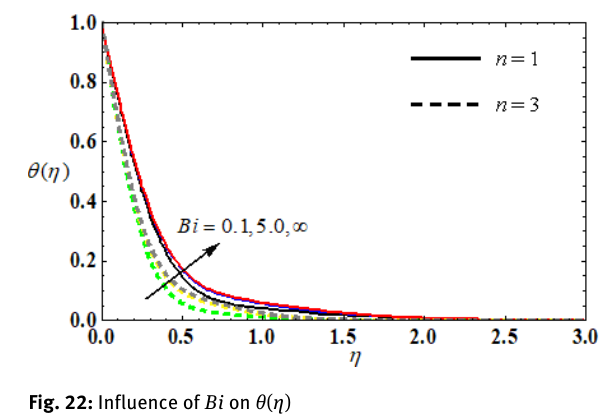
Fig. 22: Influence of Bi on θ ( η )